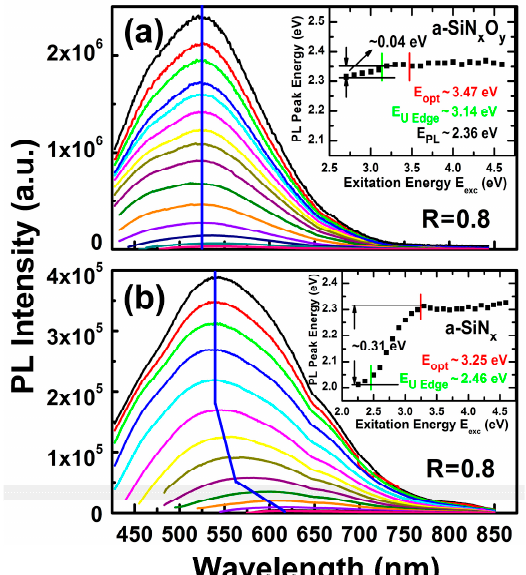
Figure 5. PL spectra of ( a ) a-SiN x O y ; ( b ) a-SiN x samples with R = 0.8 under different E exc . Insets exhibit the PL peak positions vs. E exc .